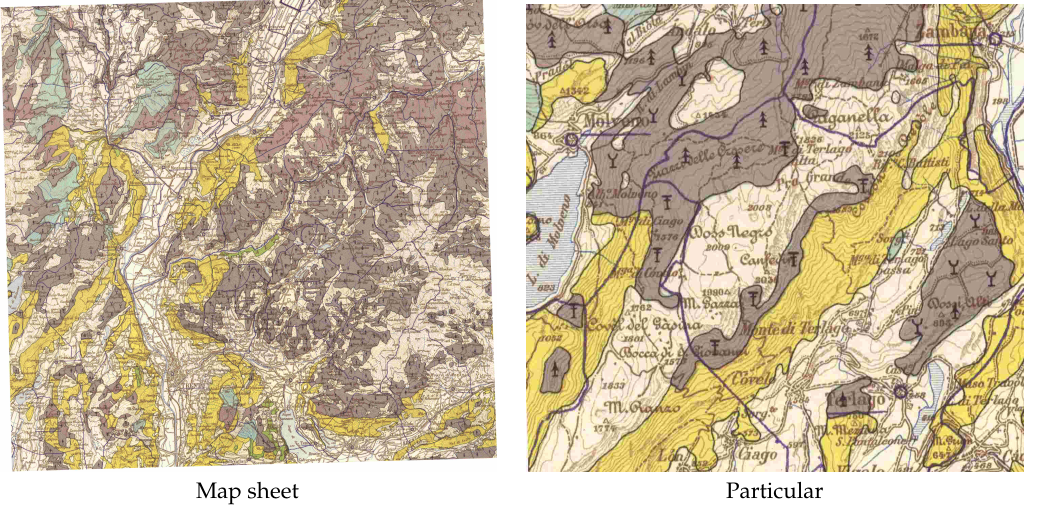
Figure 2. Map sheet of the 1936 Italian Kingdom Forest